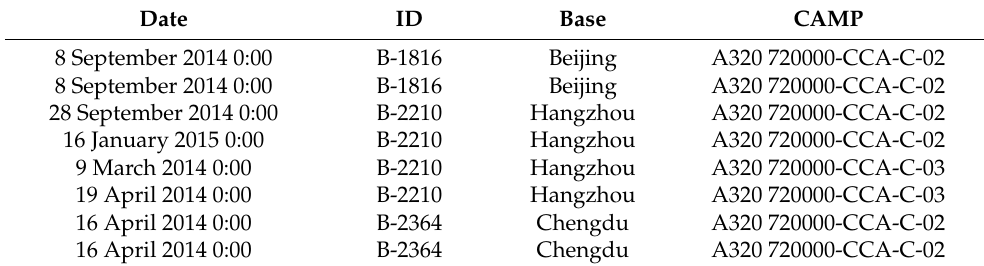
Table 5. Washing records.